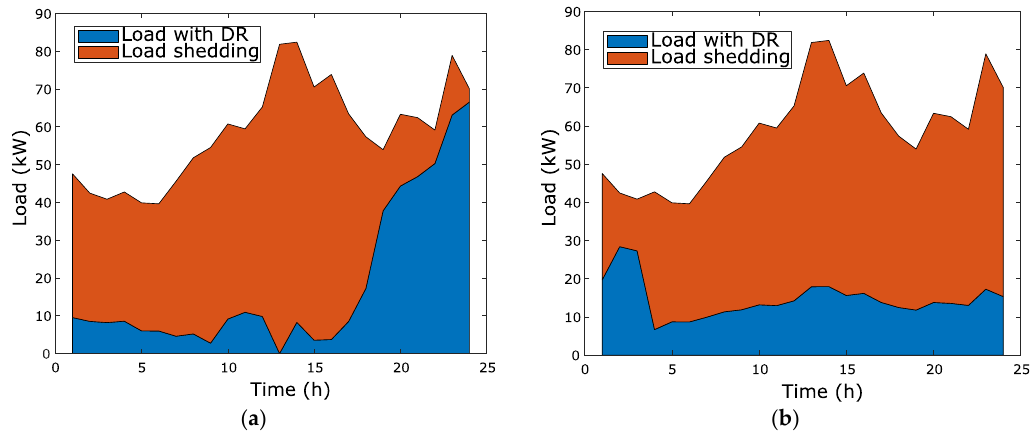
Figure 10. Demand response for all customers: ( a ) 0-1 knapsack problem; ( b ) demand response function.